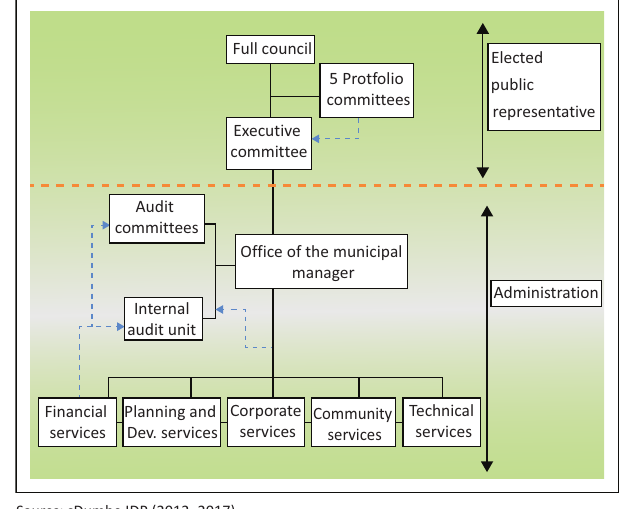
FIGURE 2 : Organisational chart (eDumbe Municipality).